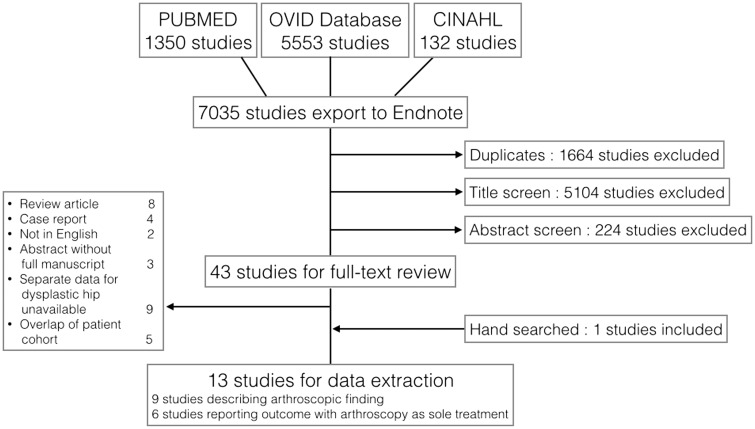
A flow diagram showing screening process.